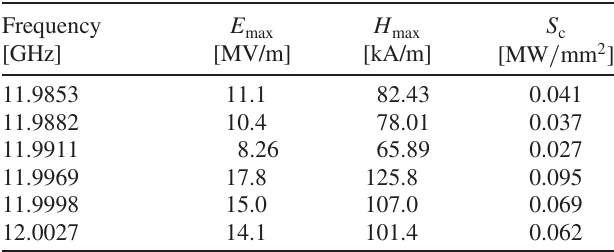
TABLE II. Rf parameters of the correction cavities. Frequency